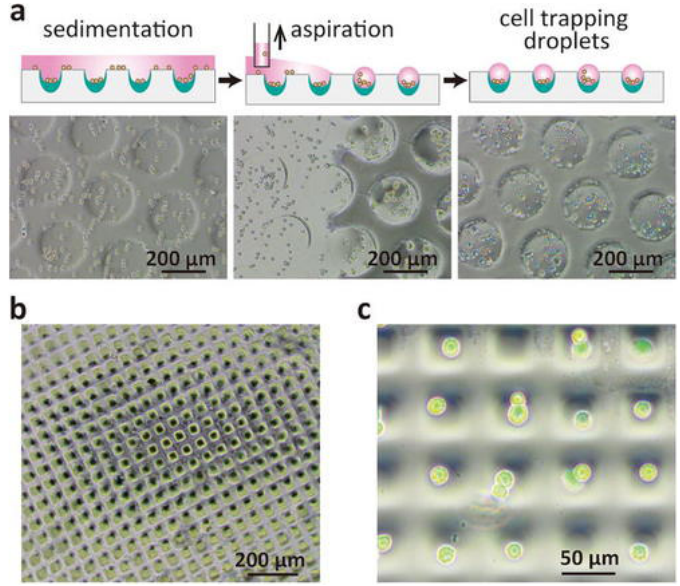
Figure 8. Schematic illustration of the cell trapping mechanism in polydimethylsiloxane (PDMS) microwells and the corresponding micrographs in ( a ) 200 µm and ( b ) 35 µm square microwell arrays. ( c ) Single-cell trapping demonstrated using a combination of bright field microscopy and fluorescence imaging. (Reprinted with permission from [68] Copyright (2018), American Institute of Physics).